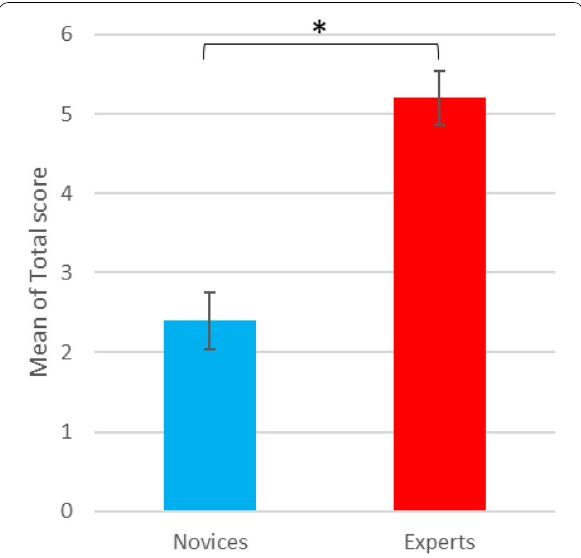
Fig. 10 Mean and SEM of the total score for reconnaissance activity. (*p < 0.05)